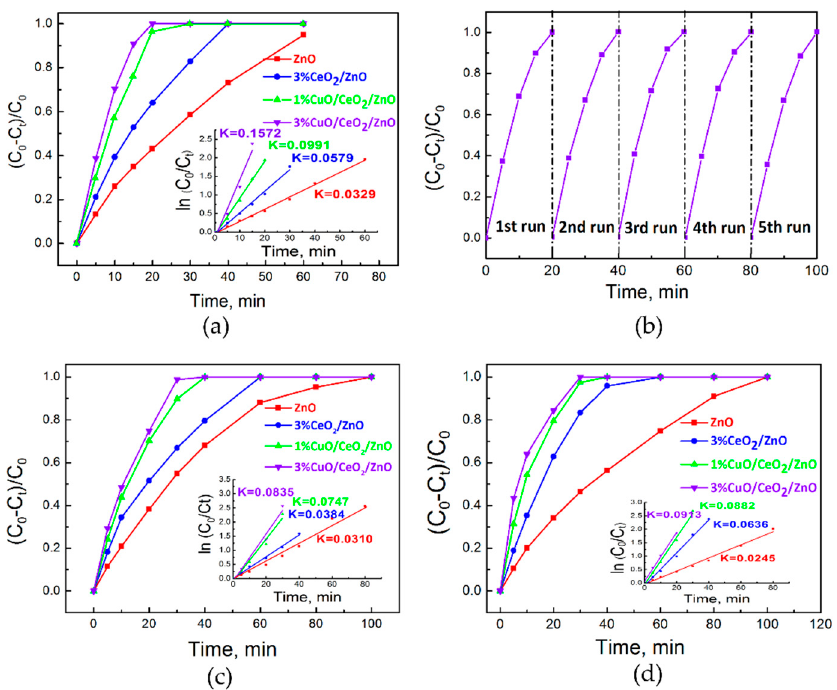
Figure 4. Photocatalytic degradation curves and the first-order kinetic constants (ln (C 0 /C t )) of the as- synthesized samples for methylene blue (MB), methyl orange (MO) and rhodamine b (RhB) decomposition. ( a ) Photocatalytic degradation of MB investigated under simulated sunlight irradiation. ( b ) Cycling experiments of MB degradation under simulated sunlight with sample 3% CuO/CeO 2 /ZnO. ( c , d ) Photocatalytic degradation of MO, RhB, respectively, investigated under simulated sunlight irradiation.